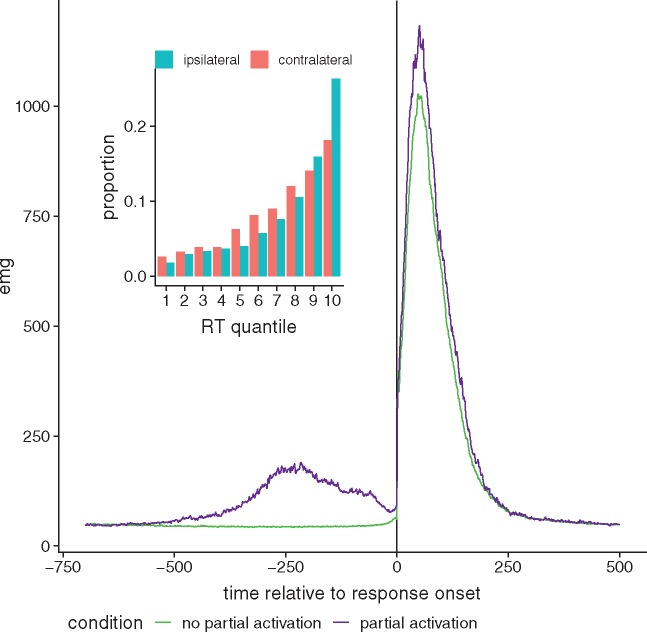
Main figure: Average EMG time course for trials with (purple) and without (green) partial activation. Trials were aligned to response onset (time = 0). Inset figure shows proportion of partial activation [ipsilateral (blue) and contralateral (red) to the response] by RT quantile, averaged across subjects.